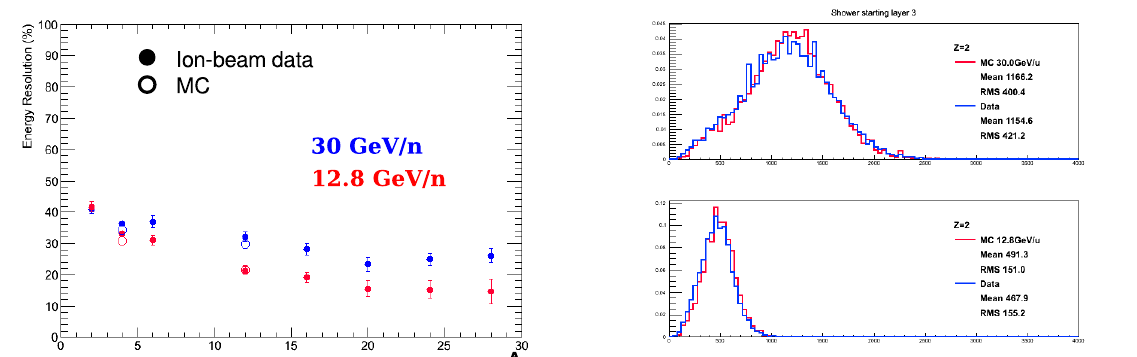
Figure 5. Left panel : Energy resolution as a function of the ion mass number and of the beam energy for showers having the same containment; Right Panel : Distribution of the energy deposit (in MIP units) of 30 GeV/n (upper panel) and 12.8 GeV/n (bottom panel) He